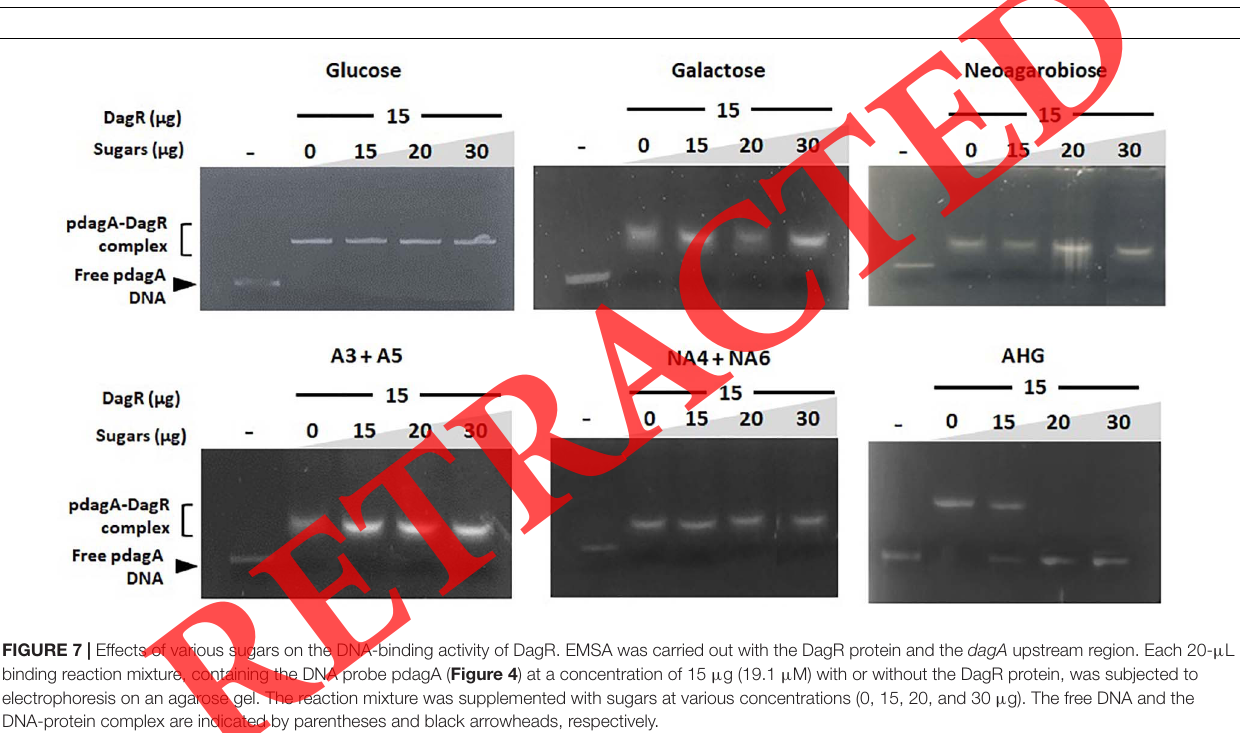
FIGURE 6 | Nucleotide sequence of the promoter regions of dagA . Sequences of DagR-binding sites are in bold and red. The transcription start sites of dagA are indicated by a circle and black arrow above the corresponding nucleotide. The putative -10 and -35 regions and the ribosomal binding sites (SD) are underlined and in green. The signal peptide sequence of DagA is underlined. The position of the PCR primers used for DNase 1 footprinting analysis is marked by a tangent arrow.